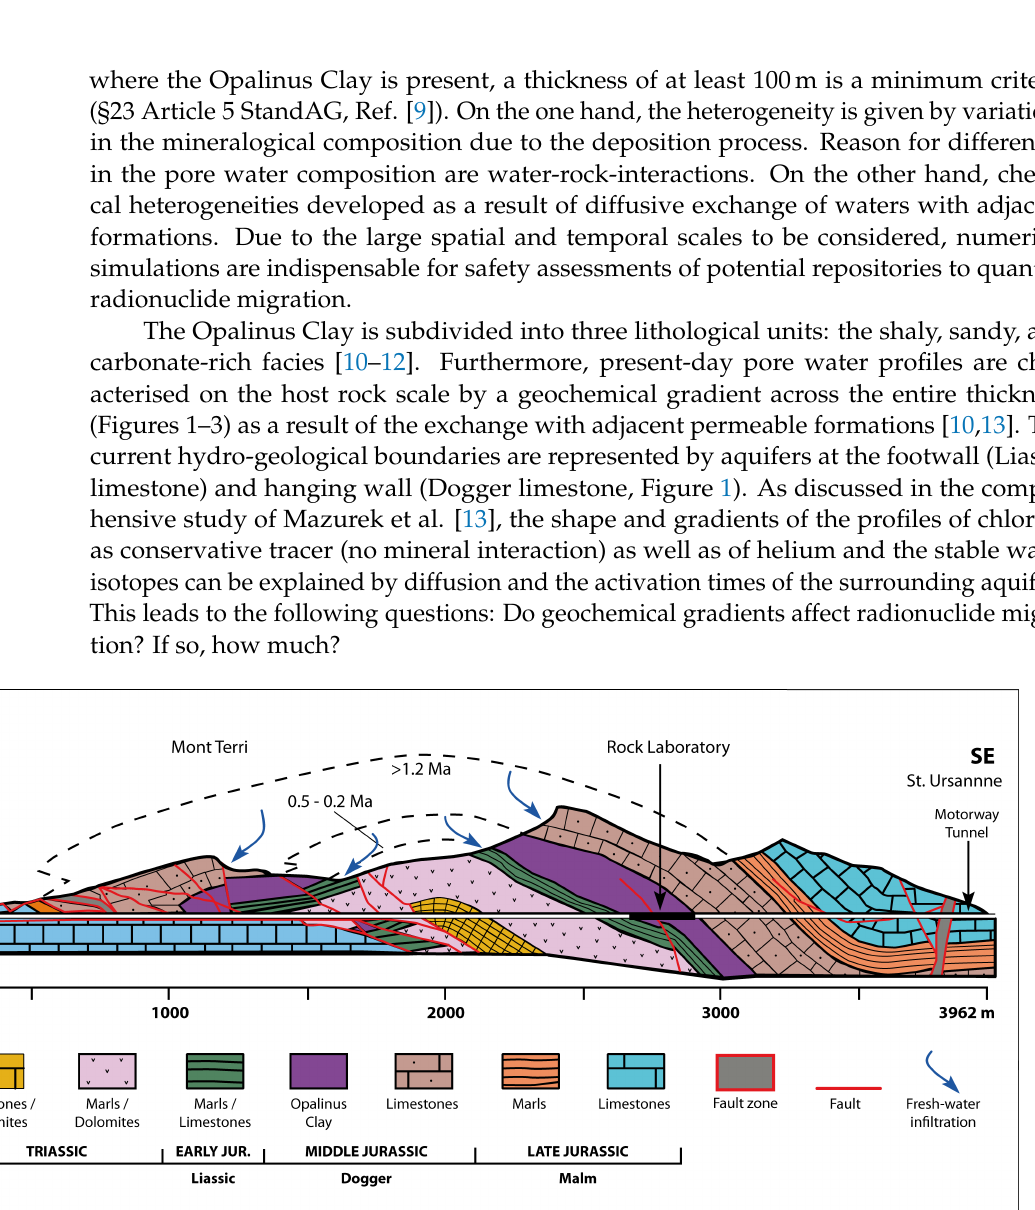
Figure 1. Erosion history of the Mont Terri anticline and associated fresh-water infiltration into the embedding aquifers of the Opalinus Clay is indicated in the geological profile by the blue arrows. (Modified from Freivogel and Huggenberger